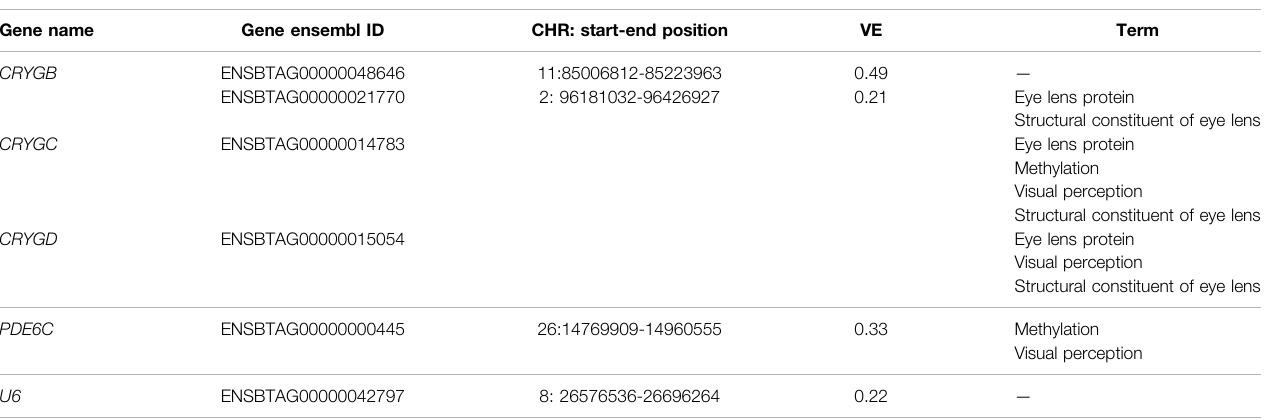
TABLE 5 | Sample of the top genomic regions, the genes, and biological processes involved in these